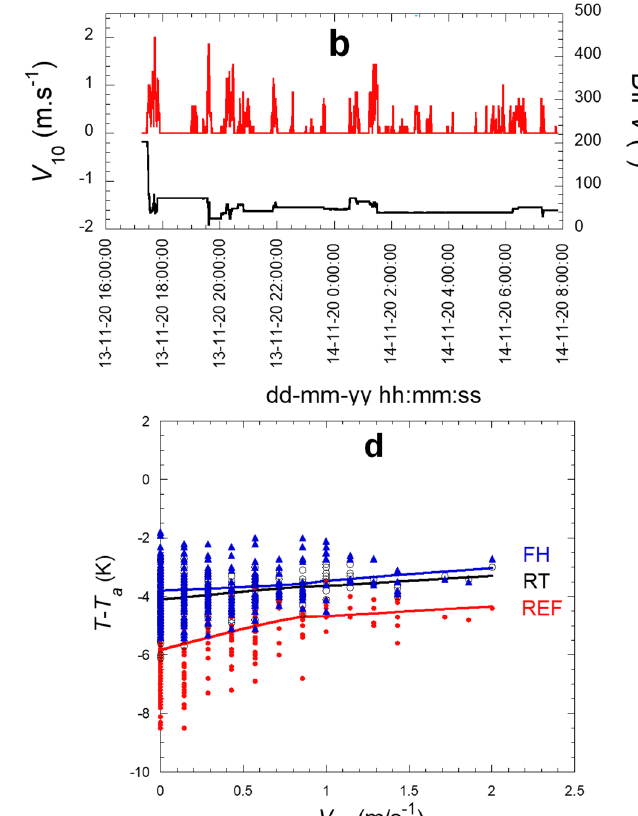
20 of 35 Figure 8. Recorded data for the reference condenser ( T 0 ) and left and right windows on the AD car for the night 6 − 7 November 2020 (hh:mm:ss, UT + 1) in Ajaccio. ( a ) Differences with air temperature T